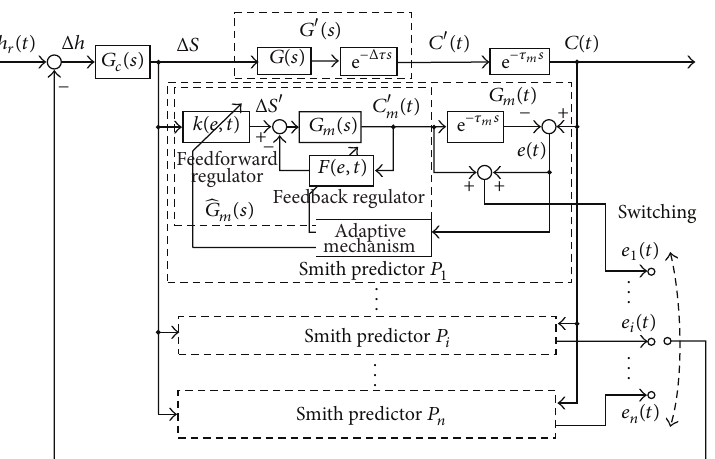
Figure 5: AGC control process based on multiple adaptive Smith prediction